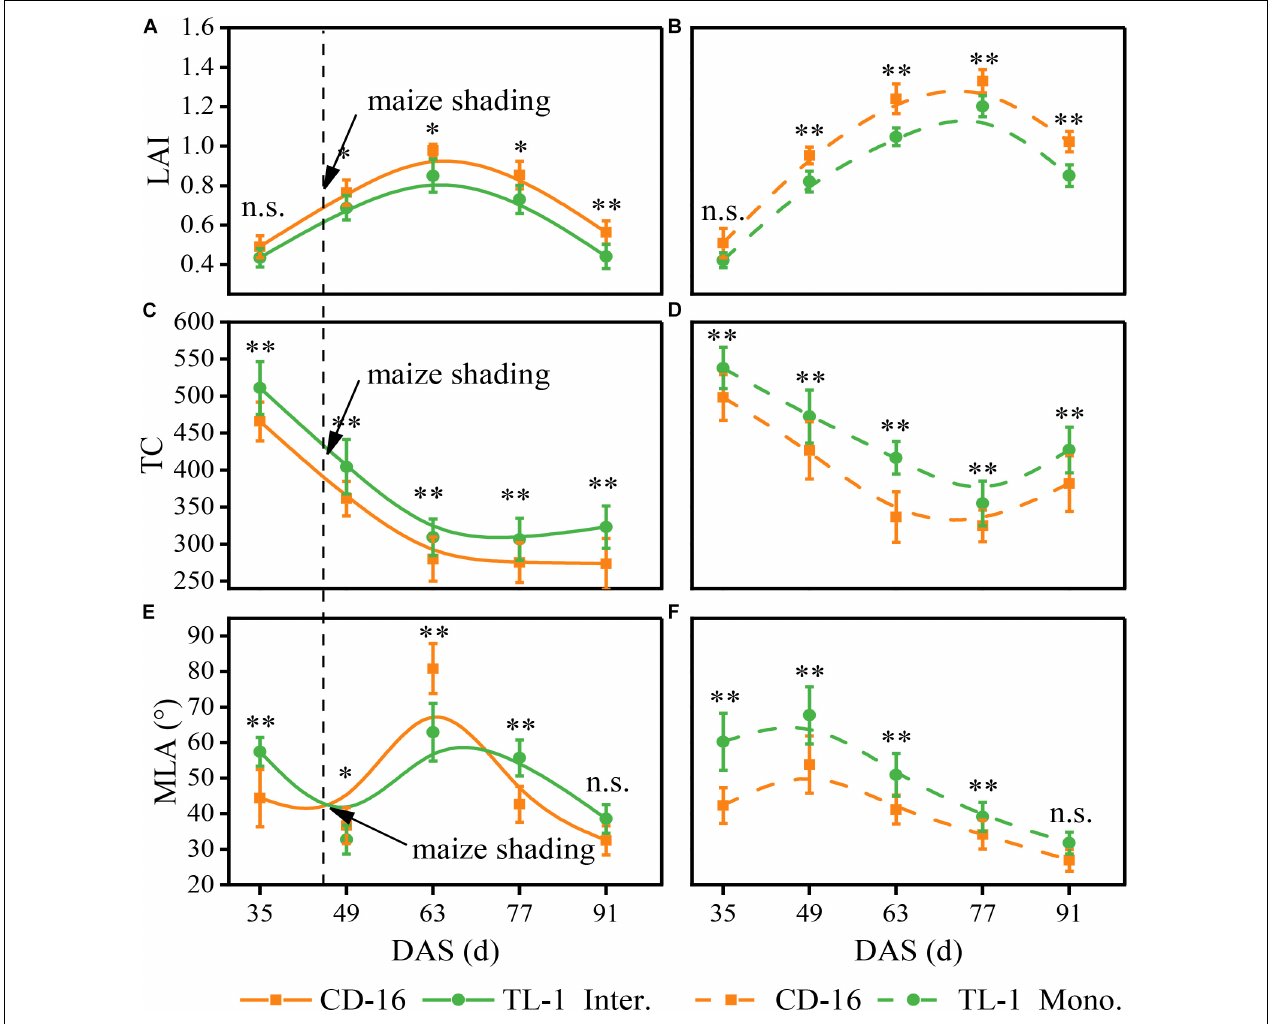
FIGURE 5 | Effects of different cultivars and planting patterns on LAI (A,B) , TC (C,D) and MLA (E,F) . The ∗ and ∗∗ indicate significant differences between CD-16 and TL-1 at the levels of P < 0.05 and P < 0.01, respectively. The n.s. means not significant at the level of p ≥ 0.05. The vertical black dotted line indicates that the maize begins to shade the intercropping soybean at this time. Data are average of three replicates. Error bars represent standard errors. The solid line indicates strip intercropping, and the dashed line indicates monoculture. The Mono. and Inter. are the abbreviation of monoculture and strip intercropping, respectively. DAS represents the number of days after